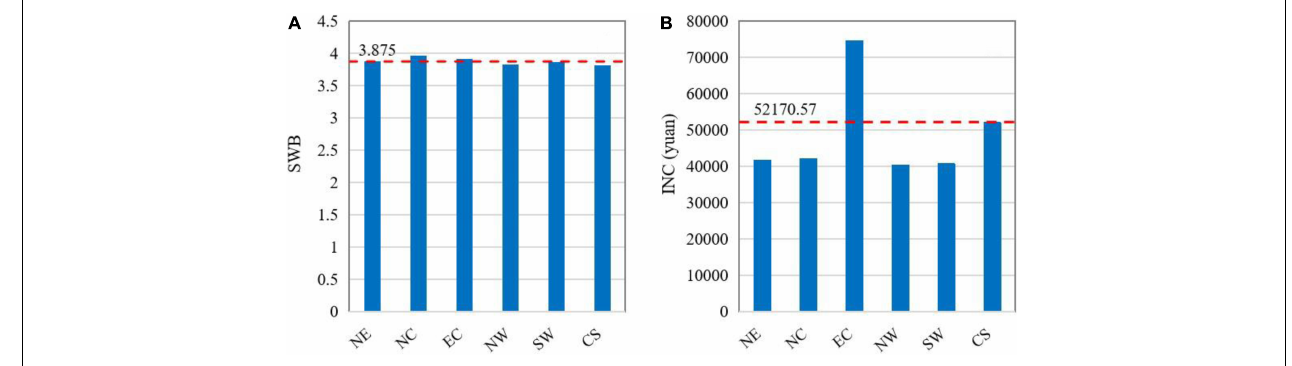
FIGURE 1 | Regional differences in farmers’ subjective well-being and income: (A) Subjective well-being; (B) Income (yuan).